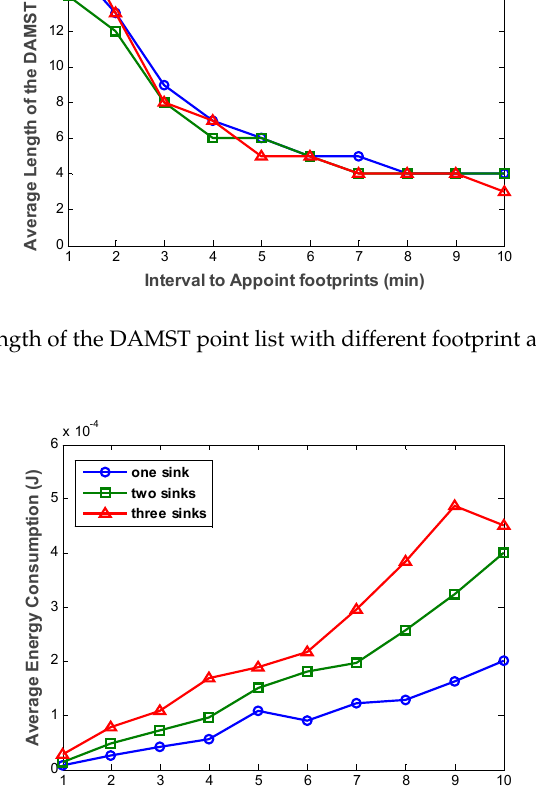
Figure 12. Average energy consumption with different footprint appointment intervals.